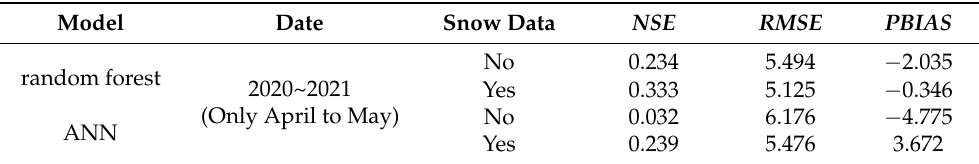
Table 5. Verification results for the random forest model and ANN model of the Xiying River Basin